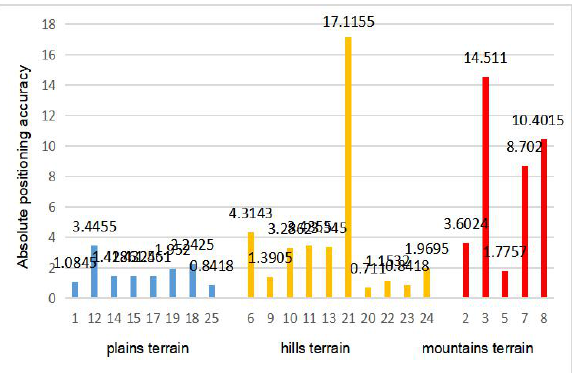
Figure 4. Absolute positioning accuracy distribution on plains (blue columns ), hills (yellow columns), and mountain (red columns)